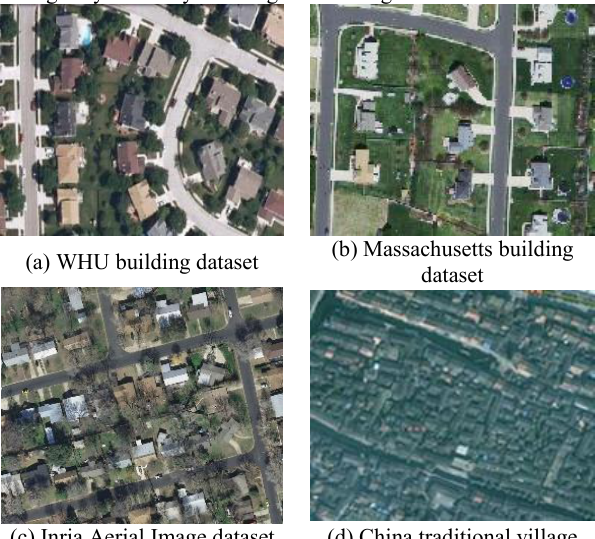
Figure 1 . Comparison of three semantic segmentation dataset images of architectural with remote sensing images of traditional Chinese